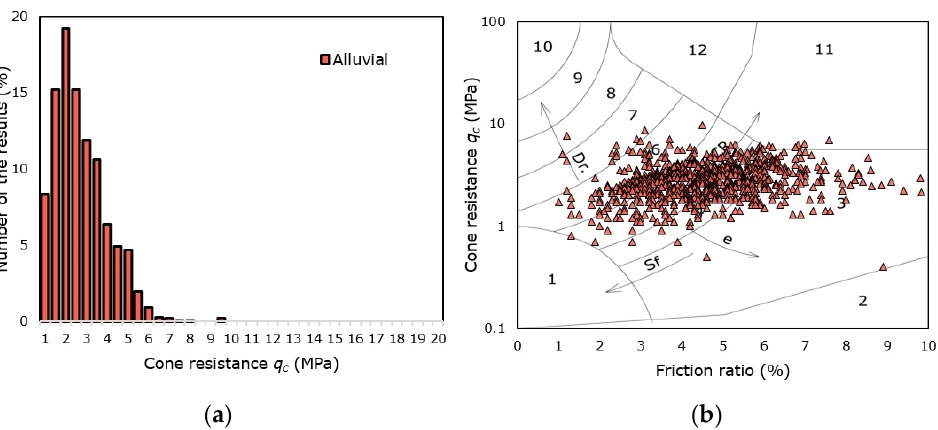
Figure 7. Summary of results for the alluvial facies: ( a ) distribution of q c values and ( b ) sounding parameters plotted against Robertson’s chart. against Robertson’s chart (1—sensitive fine grained; 2—organic material; 3—clay; 4—silty clay to clay; 5—clayey silt to silty clay; 6—sandy silt to clayey silt; 7—silty sand to sandy silt; 8—sand to silty sand; 9—sand; 10—gravely sand to sand; 11—very silty fine grained; 12—sand to clayey sand; D r —density ratio; OCR—overconsolidation ratio; Sf—sensitivity factor; e—void